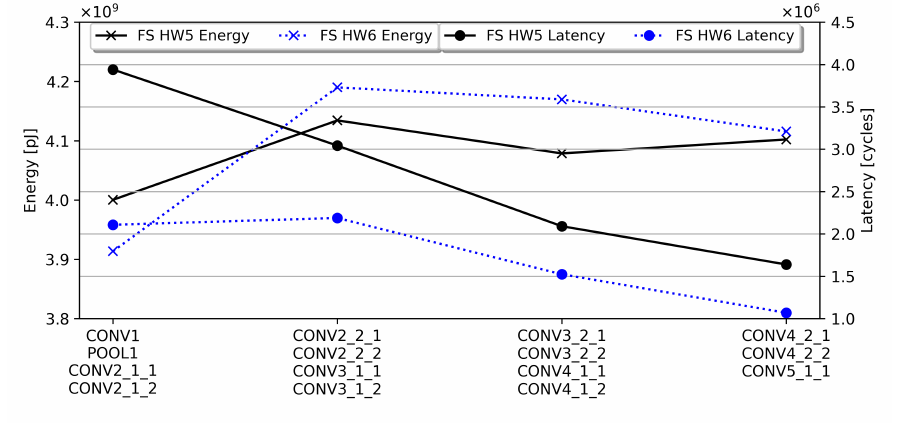
Figure 18. Energy and latency estimates for ResNet18, mapped with spatial fusion with HW config. 3 and 4.